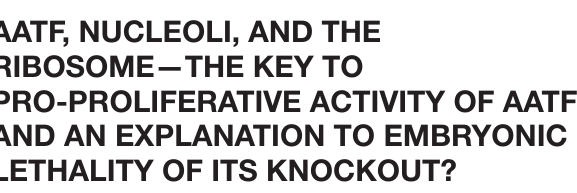
FIGURE 1 | Ataxia telangiectasia, and Rad3 related serine-protein kinase; BAK, Bcl-2 homologous antagonist/killer; BAX, Bcl-2-associated X protein; CHK1/2, Serine/threonine-protein kinase Chk1/2; CDKN1, Cyclin dependent kinase inhibitor 1; GADD45, Growth arrest and DNA damage-inducible protein GADD45 alpha; MDM2, Mouse double minute 2 homolog; MK2, MAP kinase-activated protein kinase 2; PARP1, Poly(ADP-ribose) polymerase 1; PUMA, p53 upregulated modulator of apoptosis; RNAPII/RNA POL II, RNA polymerase II; RPRM, Protein